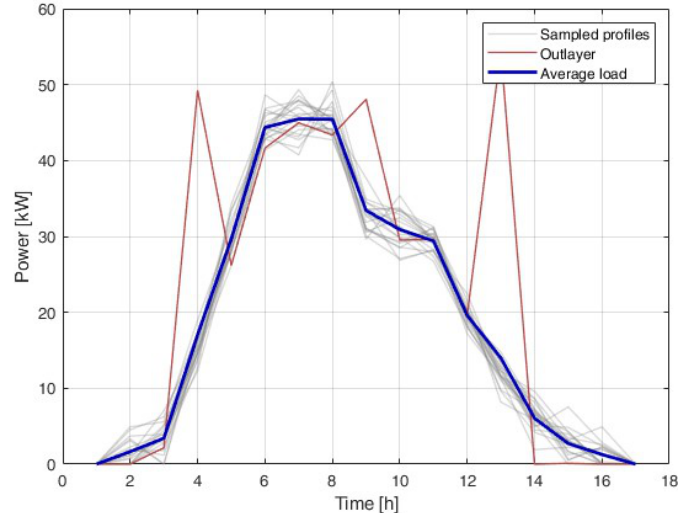
Figure 2. Example of computation of average load. Each sampled profile is represented in grey, the red line shows an outlier, while the blue line is the average profile used in the optimisation.